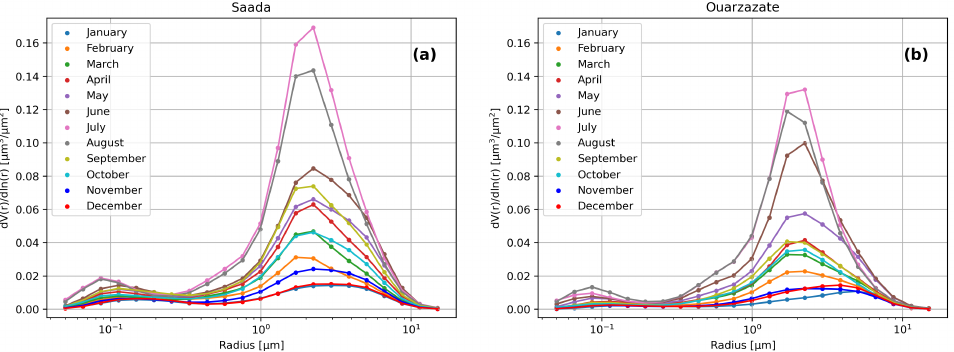
Figure 3. Monthly averaged AOD at 440 nm wavelength (blue line with the vertical axis on the left) and AE at the 440–870 nm wavelength range (red line with the vertical axis on the right) values as derived from AERONET data at Saada ( a ) and Ouarzazate ( b ) sites. The vertical bars indicate the corresponding standard-deviations.